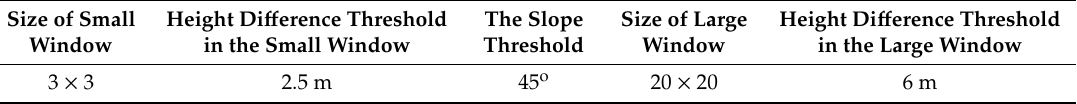
Table 2. Parameter values in the slope and progressive window thresholding (SPWT) algorithm for filtering the LiDAR dataset.